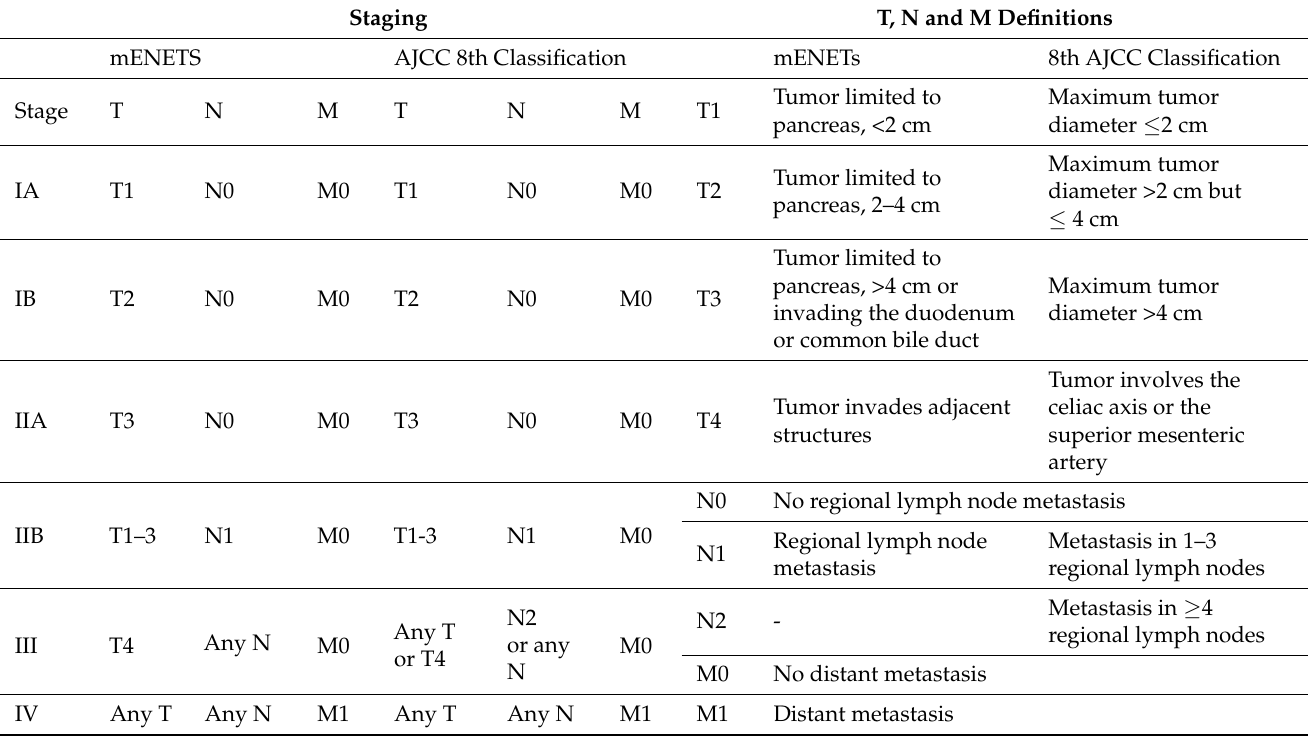
Table 2. Staging system according to the modified ENETS and AJCC 8th staging classifications